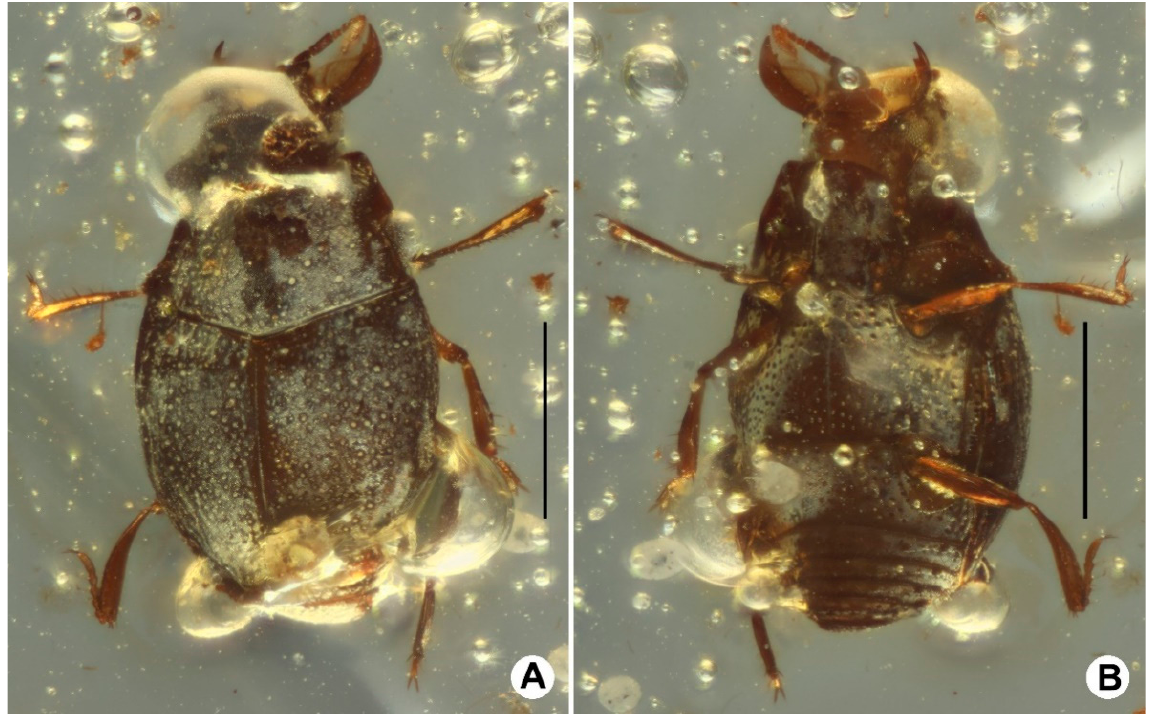
Figure 1. Habitus of Anapleus kachinensis sp. nov., holotype, GUGC-FOSSIL-0002. ( A ) Dorsal view. ( B ) Ventral view. Scalebars: 0.5 mm. Prosternal keel (Figure 2E) emarginate at base, with widely separated, parallel carinal striae (Figure 2E) extending onto base of prosternal lobe, keel flat between; prosternal lobe (Figure 2E) distinctly arcuate, surface finely covered with large round punctures. Antennal fissures (Figure 2C) longitudinal. Prosternal keel striae (Figure 2E) almost continuous with marginal stria of the prosternal lobe. Procoxae widely